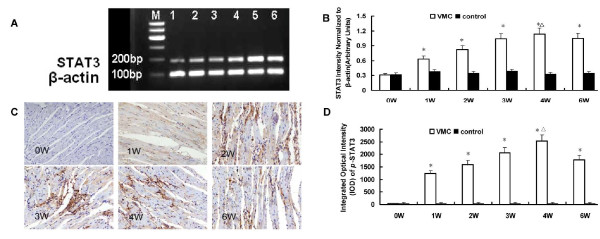
STAT3 mRNA and p-STAT3 protein expression in the myocardium of VMC mice. A. Strong expression of STAT3 occurred from 1st week to 6th week after CVB3 infection. M: Maker; 1: week 0; 2: week 1; 3: week 2; 4: week 3; 5: week 4; 6: week 6. B. Densitometric quantitation of STAT3. STAT3 mRNA expression was elevated in VMC mice from 1st week to 6th week, ΔP < 0.01, versus control group. ΔP < 0.05, versus week 0, 1 and 2. C. Representative of p-STAT3 immunohistochemistry images in heart tissue of VMC mice (Dark brown stain in cytoplasm, original magnification × 400). D. Morphometric quantitation of p-STAT3 protein expression in heart. ΔP < 0.05, versus control group, ΔP < 0.05, versus week 0, 1, 2 VMC mice.